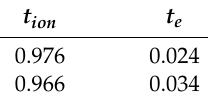
Table 3. Calculated transference numbers of ions and electrons.